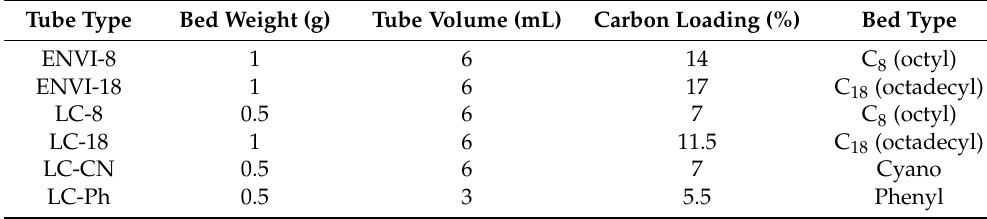
Table 2. Characteristics of Supelclean™ tubes applied to solid phase extraction.